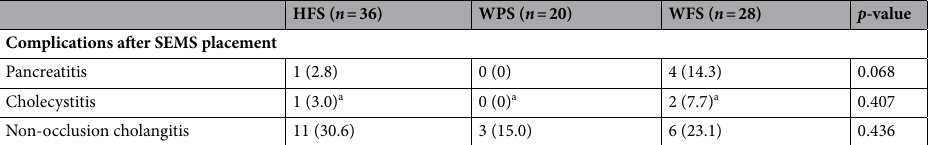
Table 4. The incidences of SEMS-related complications. Data are presented as median (range) or number (proportion). SEMS Self-expandable metal stent, HFS HILZO fully covered stent, WPS WALLFLEX biliary RX partially covered stent, WFS WALLFLEX biliary RX fully covered stent. a Patients who had undergone cholecystectomy were